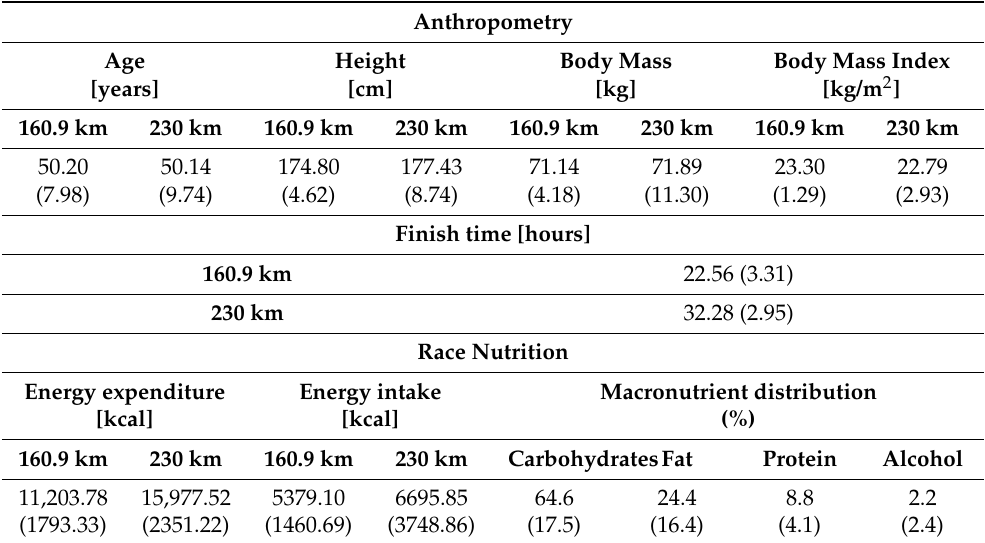
Table 1. Anthropometric data, finish time, and nutrition details of the study participants. All data are presented as mean standard ±